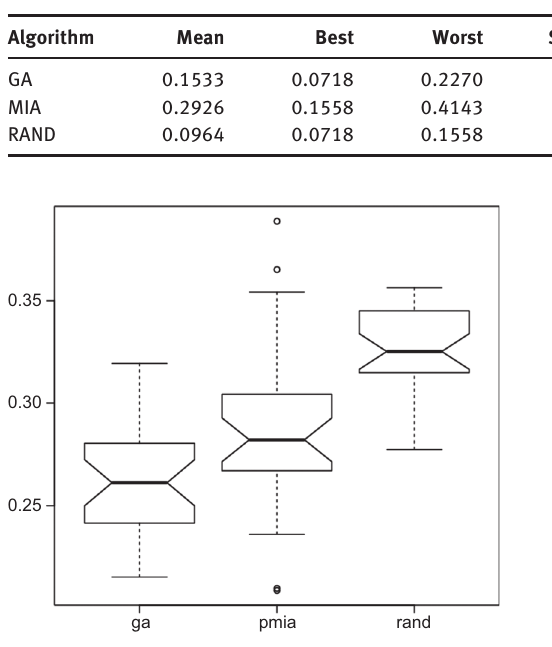
Figure 1. Length 13 2 PSK Box Plot Results.